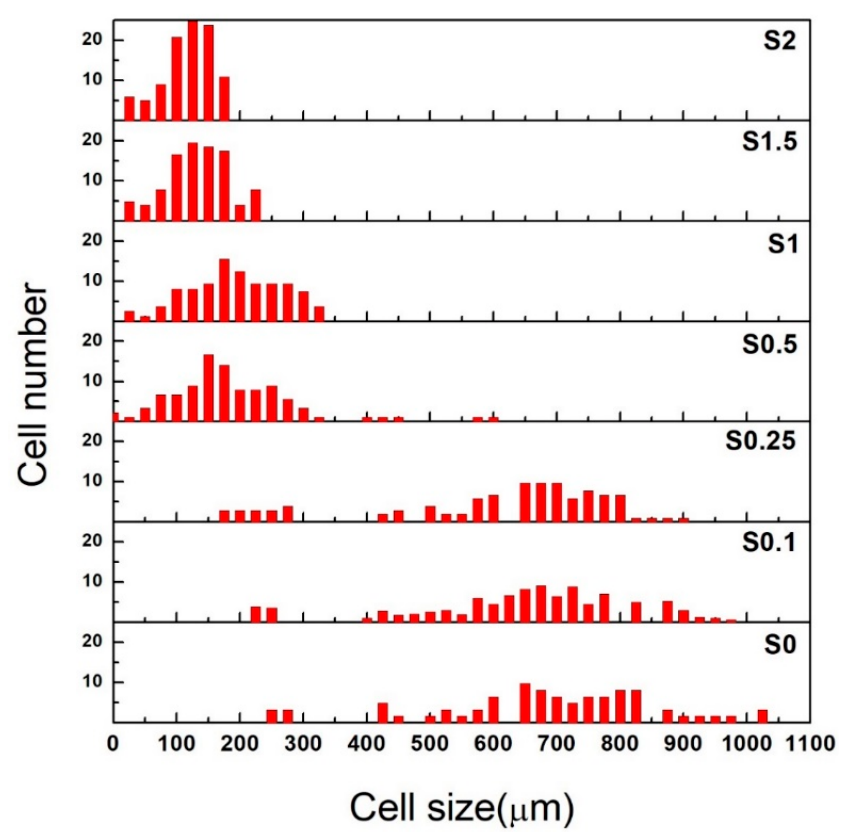
Figure 3. Cell size distribution of NR/CNT/GNS nanocomposite foams .